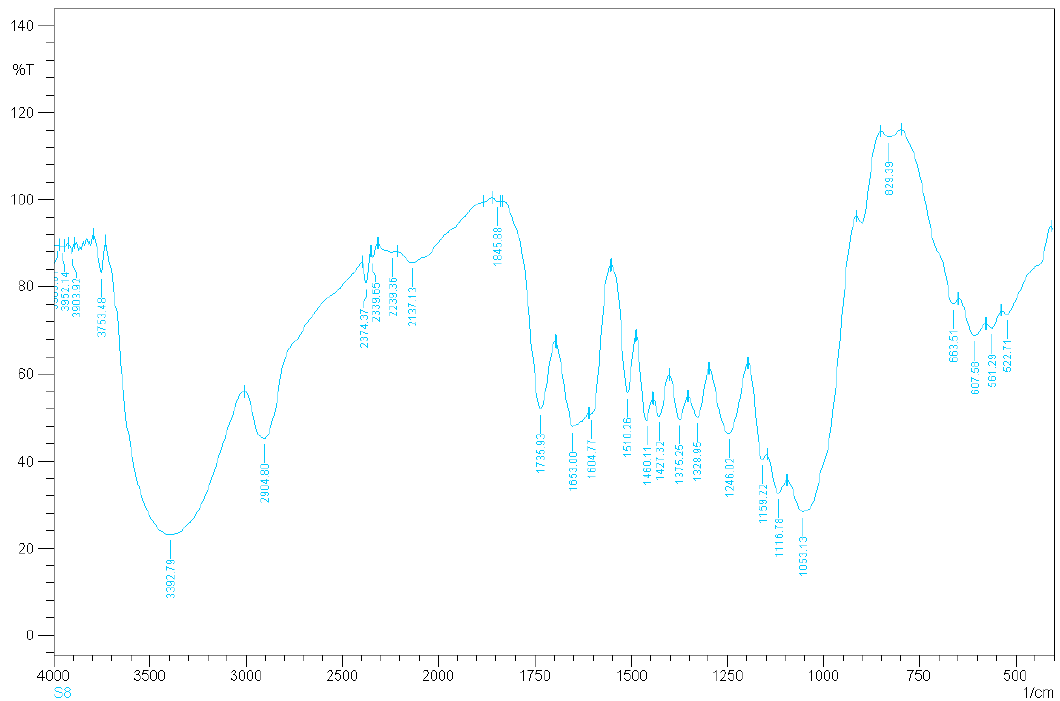
Figure 2. Transmittance spectrum of Rhizophora spp. particleboard bonded with 6% binders.